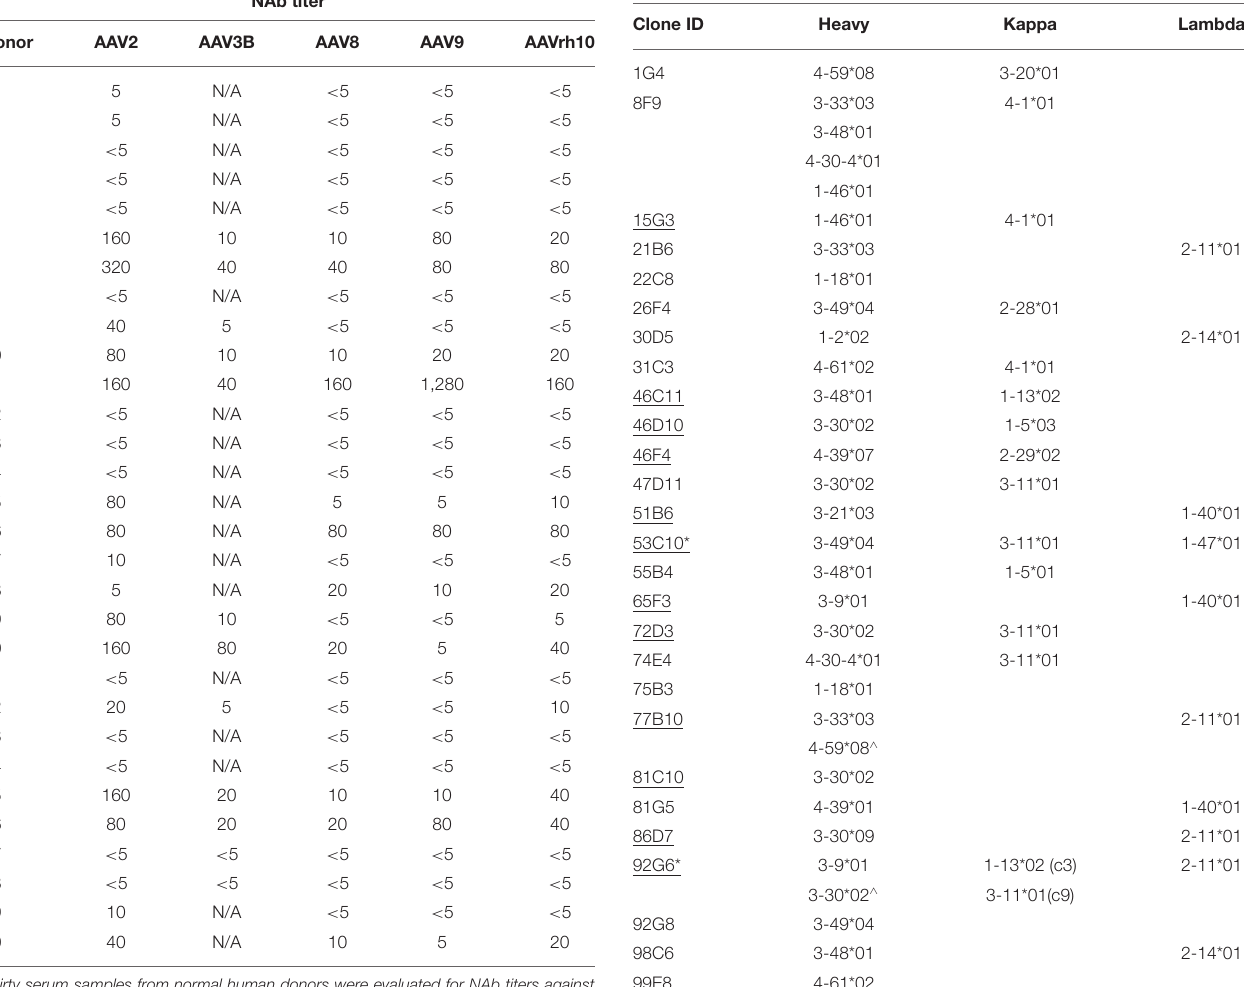
TABLE 1 | NAb titers of normal human donors against AAV. TABLE 2 | List of isolated anti-AAV antibody sequences and corresponding IMGT germline